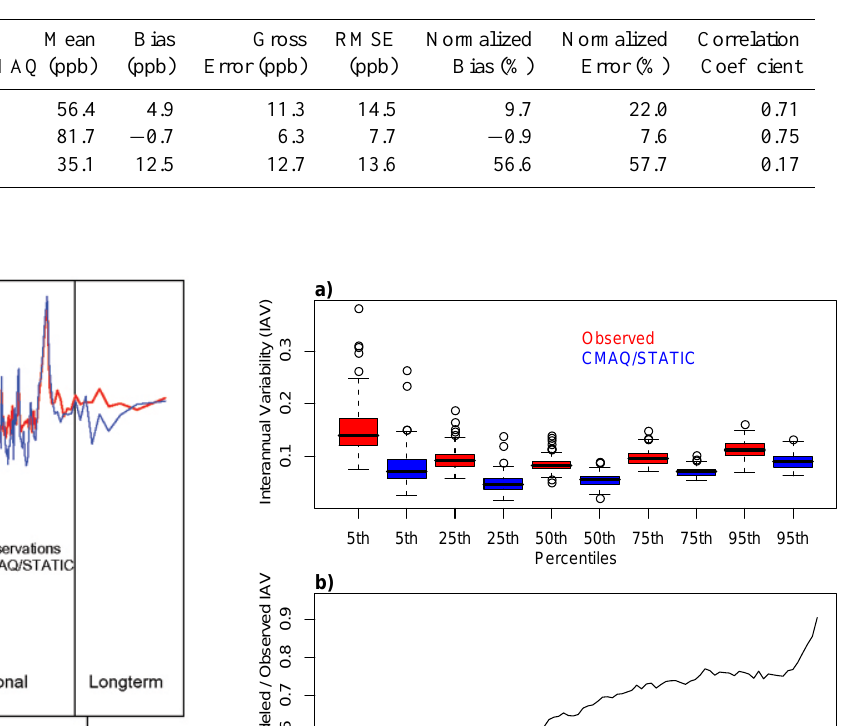
Table 3. Model performance metrics calculated for the CMAQ/STATIC simulated daily maximum 8-h ozone concentrations at 90 monitors for 1988–2005. Metrics for the “All days” row were calculated using all observed and simulated values for May–September for each year. Metrics for the 5th and 95th percentile rows were calculated by first determining the corresponding percentile from the 153 daily May– September values for each year and then calculating the metrics across the 18 years from 1988–2005. All metrics were calculated separately at each monitor and then averaged for display in this Table.